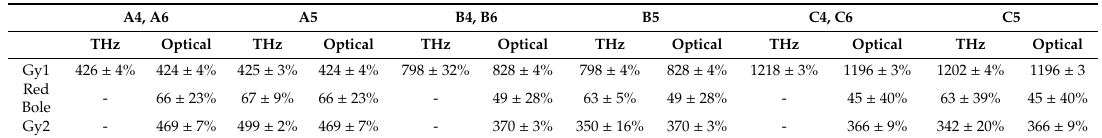
Table 1. THz estimate and optical measurement of layer thickness (in microns) of six areas not covered by brass varnishes.